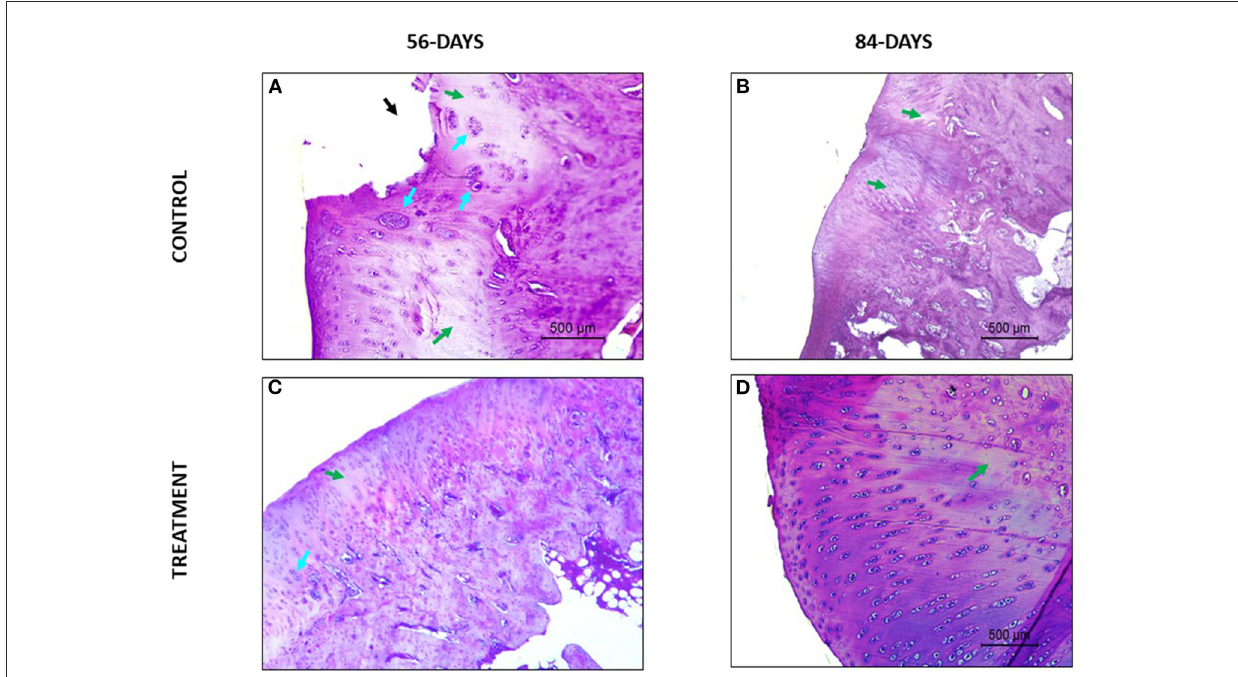
FIGURE6 Hematoxylin-Eosin stained sections. Green arrows point areas of chondrocyte density decrease and blue arrows point chondrocytes clusters. (A) Lack of superficial and mid zones of the articular cartilage (black arrow), chondrocyte clustering and multifocal and confluent eosinophilic areas with lack of chondrocytes. (B) Eosinophilic areas with diminished chondrocyte density and structural disorganization. (C) Focal areas of hypocellullarity and some chondrocytes aggrupation. (D) Good chondrocytes organization and morphology (oval and rounded cells organized in columns) without cluster presence and basophilic extracellular